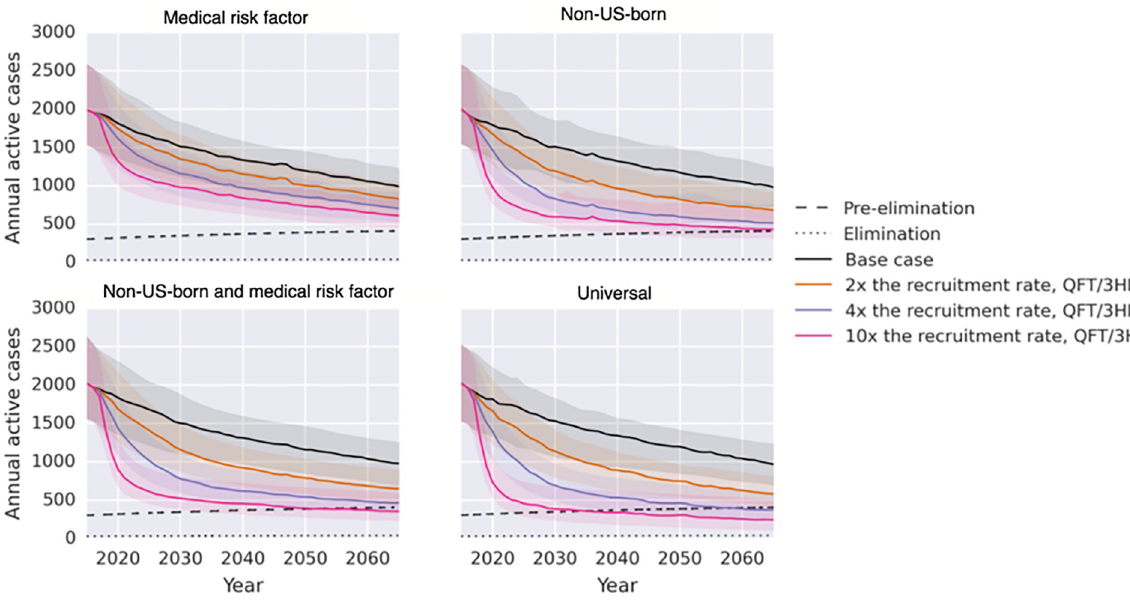
Fig 3. Annual cases of TB projected for 2017–2065, for LTBI test and treat strategies targeted to those with medical risk factors, the non- USB, both of these groups, and all (universal), for 2, 4, and 10-fold increases in testing rates. Dotted and dashed lines show elimination and pre-elimination targets. Solid lines represent mean cases from 250 iterations using best available estimates. Shaded areas represent 95% confidence interval from 250 iterations using probabilistic sensitivity